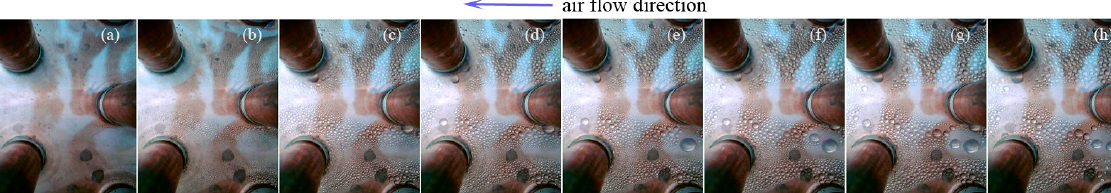
Figure 4. Condensate droplets on the copper fin surface: ( a ) τ = 10 s, ( b ) τ = 60 s, ( c ) τ = 120 s, ( d ) τ = 160 s, ( e ) τ = 200 s, ( f ) τ = 230 s, ( g ) τ = 260 s, ( h ) τ = 290 s.